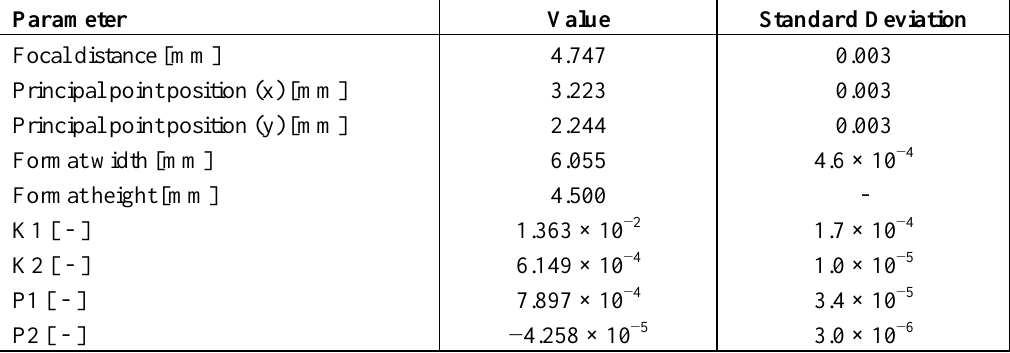
Table 2. Calibration Values employed during the recoding of the GANZ CMH212.